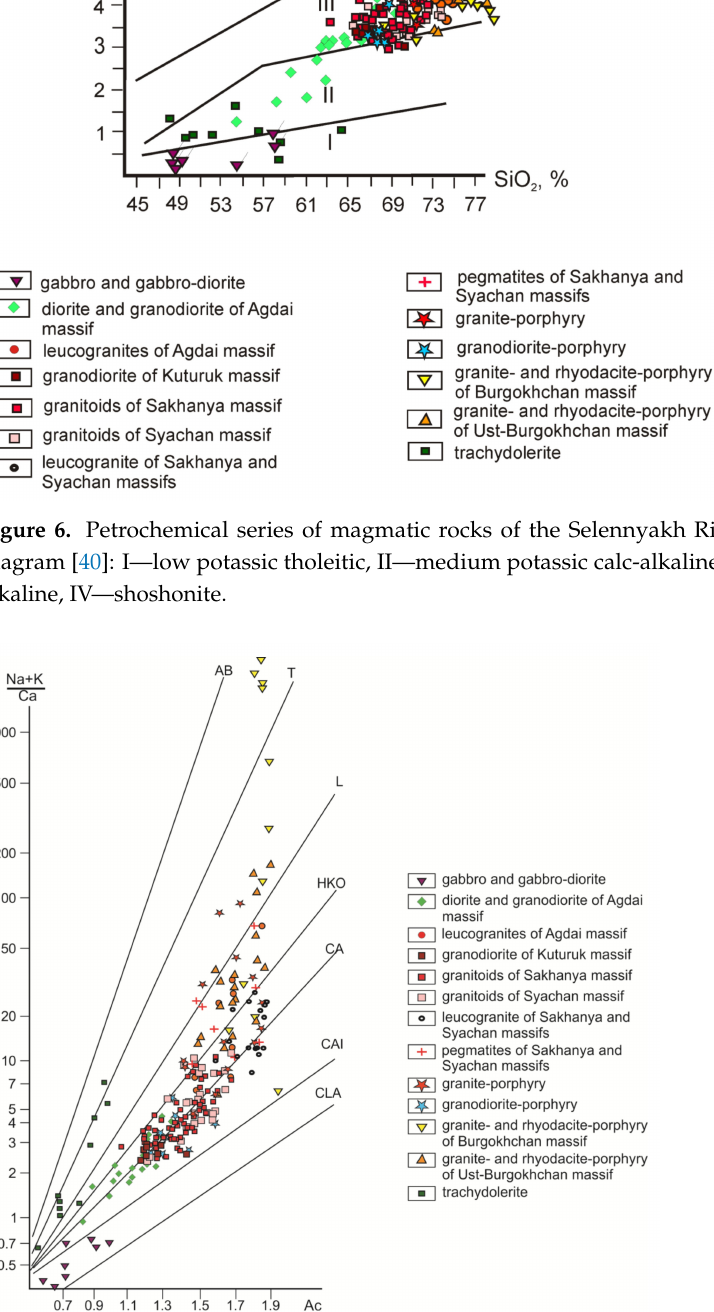
Figure 7. Magmatic series of magmatic rocks of the Selennyakh River basin. Symbols [41]: Ac-cation activity; trends of evolution: CAI—calcareous low-alkaline (island-arc), CA—calcareous-alkaline (crustal), HKO—high-potassium (orogenic), L—latite, T—trachite;